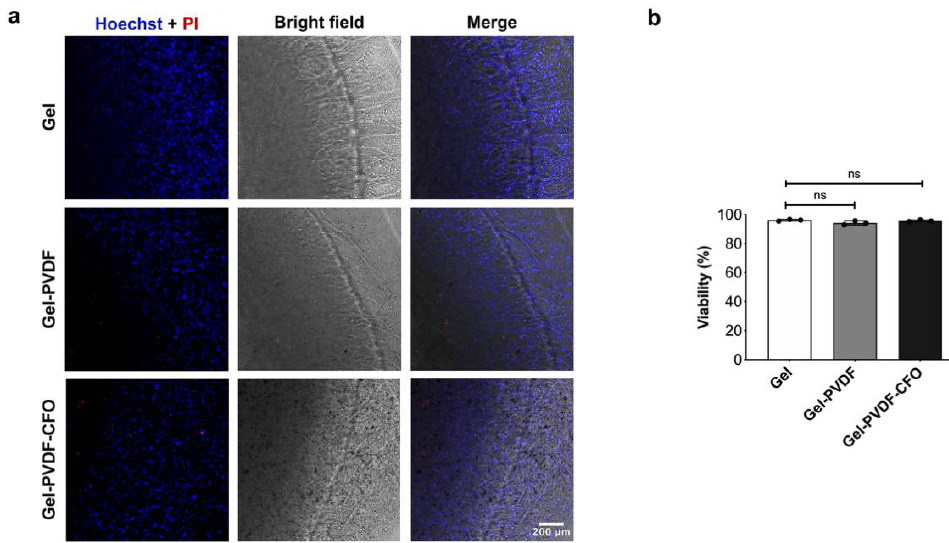
Figure 2. Viability assessment of MSCs encapsulated in gelatin hydrogels (Gel), gelatin hydrogels containing PVDF (Gel-PVDF) or PVDF-CFO (Gel-PVDF-CFO) microspheres after 24 h in culture. ( a ) Representative fluorescence microscope images of cell nuclei (Hoechst-blue) and dead cell nuclei (propidium iodide (PI)-red) merged with hydrogel bright field images. Scale bar 200 µm. ( b ) Quan- tification of cell viability ( n = 3). Statistical differences were determined by non-parametric Kruskal- Wallis and Dunn’s multiple comparison test (ns indicates non-significant differences).